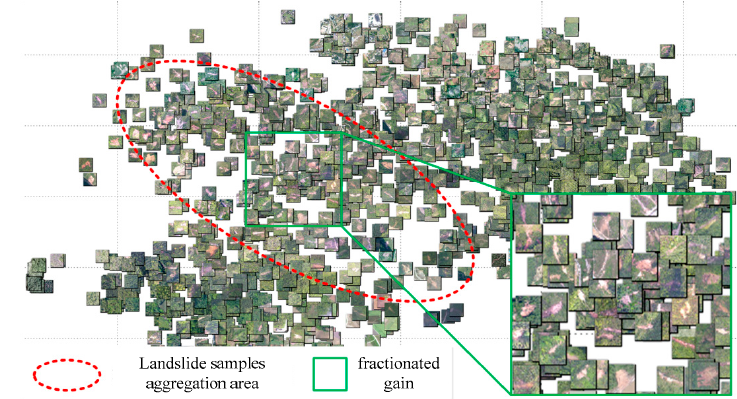
Figure 14. The t-Distributed Stochastic Neighbor Embedding (t-SNE) visualization result of landslide interpretation model feature based on TL feature.